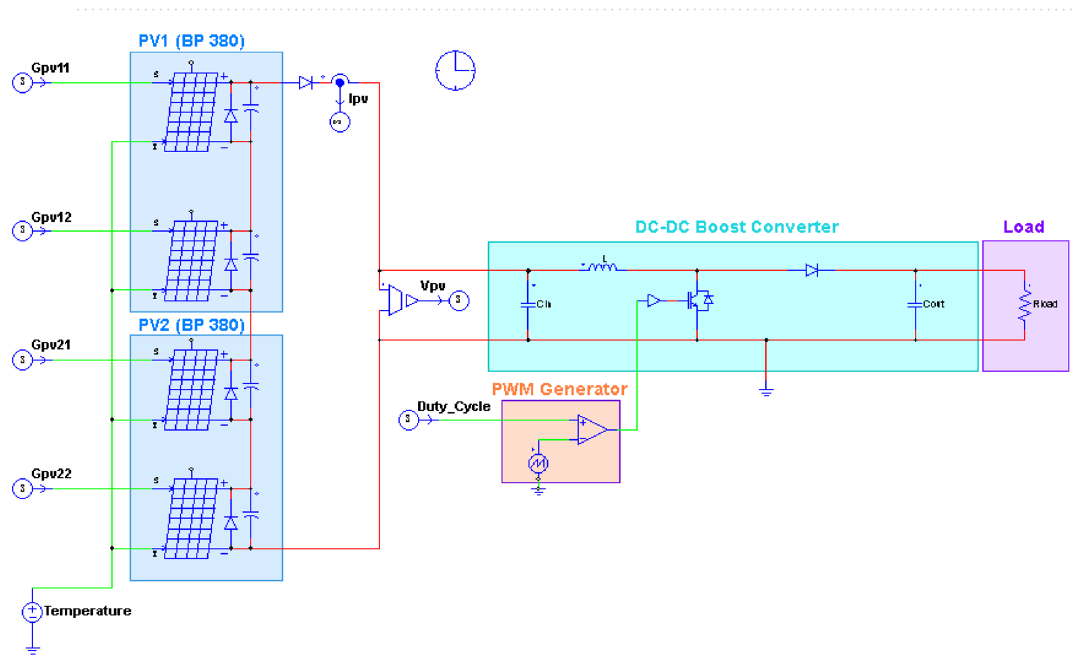
Figure 8. Implemented simulink model for MPPT controller.